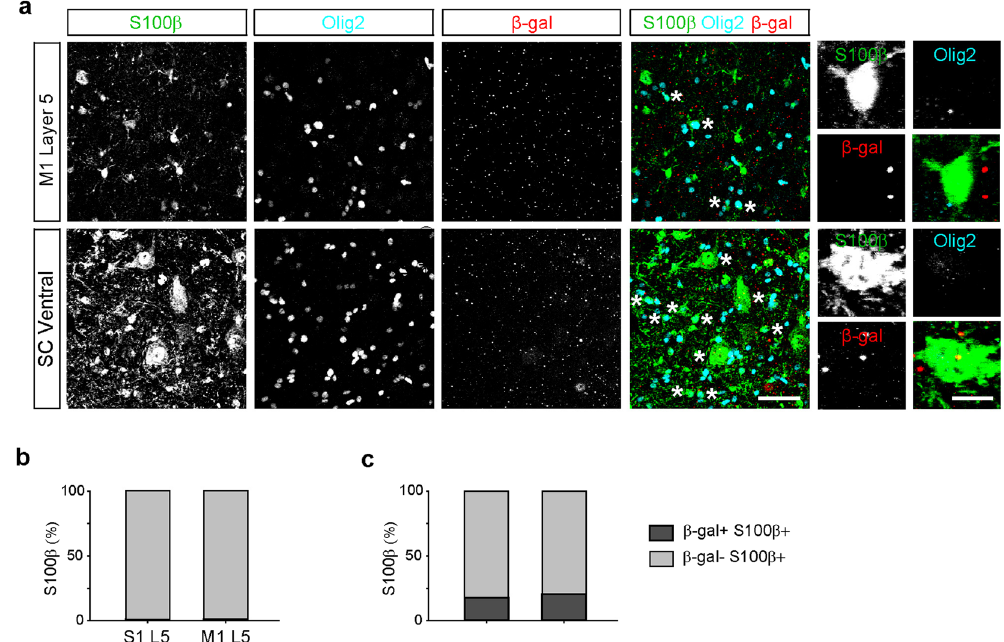
Figure 5. Differential C9orf72 promoter activity in cortical and spinal cord astrocytes. ( a ) Representative images of layer 5 (L5) in primary motor cortex (M1, top ) and the ventral horn of the spinal cord (SC, bottom ) of C9orf72 LacZ/ + mice immunostained for S100 β -positive astrocytes (green), Olig2-positive oligodendrocyte lineage cells (cyan), and β -gal (red). Asterisks indicate S100 β -positive Olig2-positive oligodendrocyte lineage cells and S100 β -positive motor neurons which were excluded from the analysis. High magnification images show an astrocyte in motor cortex which lacks β -gal puncta ( top right ) and astrocytes in the spinal cord which contain β -gal puncta ( bottom right ). Scale bars: 50 μ m and 10 μ m. Percentage of astrocytes containing β -gal puncta in L5 of primary motor and primary somatosensory cortex ( b ) L5 motor cortex: 1 of 92 cells, 1.1%, L5 somatosensory cortex, 1 of 98 cells, 1.0%, n = 3 mice for each group, p = 0.9641, Chi-Square test) and spinal cord ( c ) dorsal spinal cord: 15 of 84 cells, 17.9%, ventral spinal cord: 16 of 78 cells, 20.5%, n = 3 mice for each group, p = 0.6676, Chi-Square